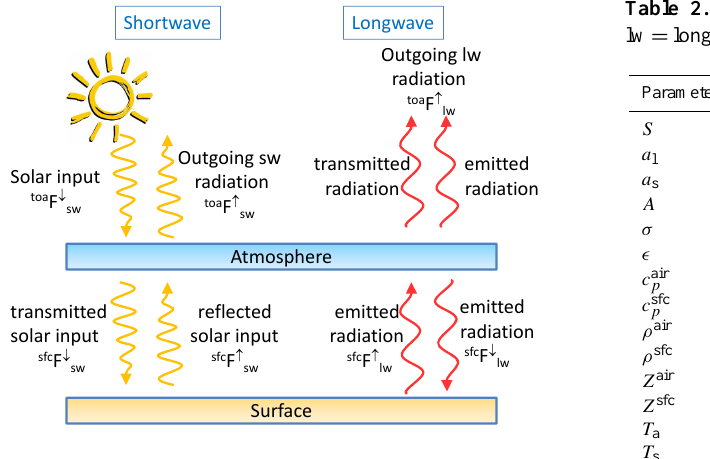
Fig. 1. Sketch of a simple climate box model.